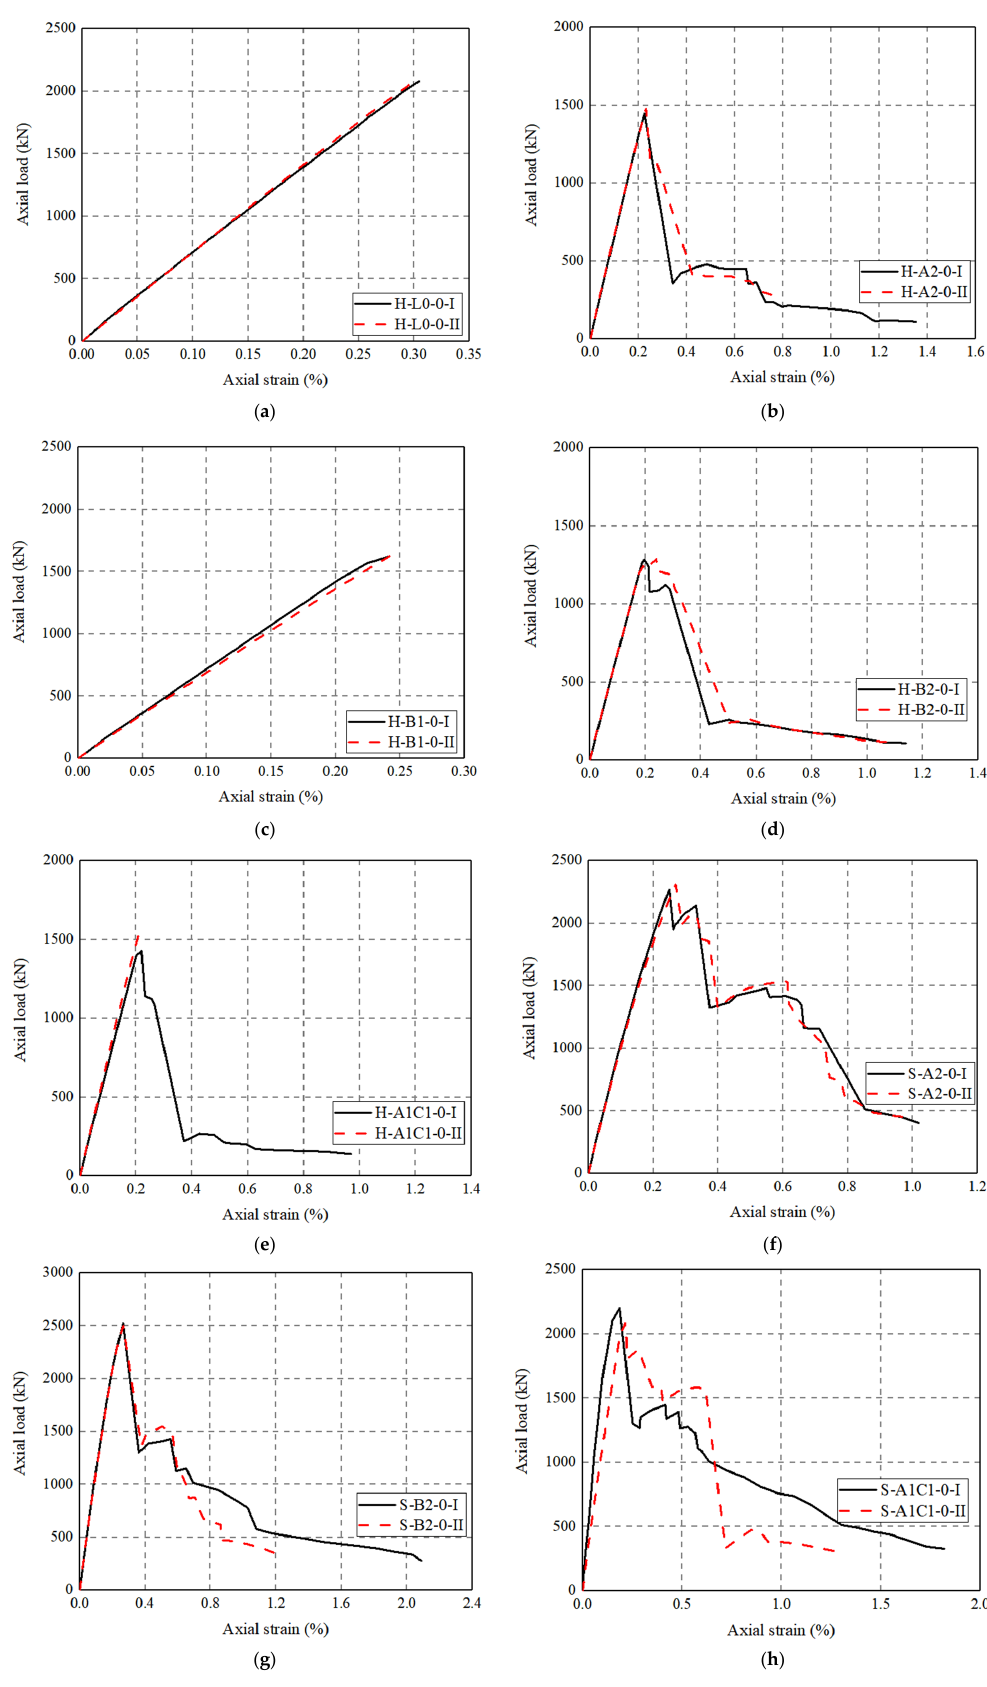
Figure 9. Typical failure modes of test columns. ( a ) H-L0-0-II; ( b ) H-A2-0-II; ( c ) H-B2-0-II; ( d ) H- A1C1-0-I; ( e ) S-A2-0-II; ( f ) S-B2-0-I; ( g ) S-A1C1-0-I; ( h ) S-A1C1-2-I.